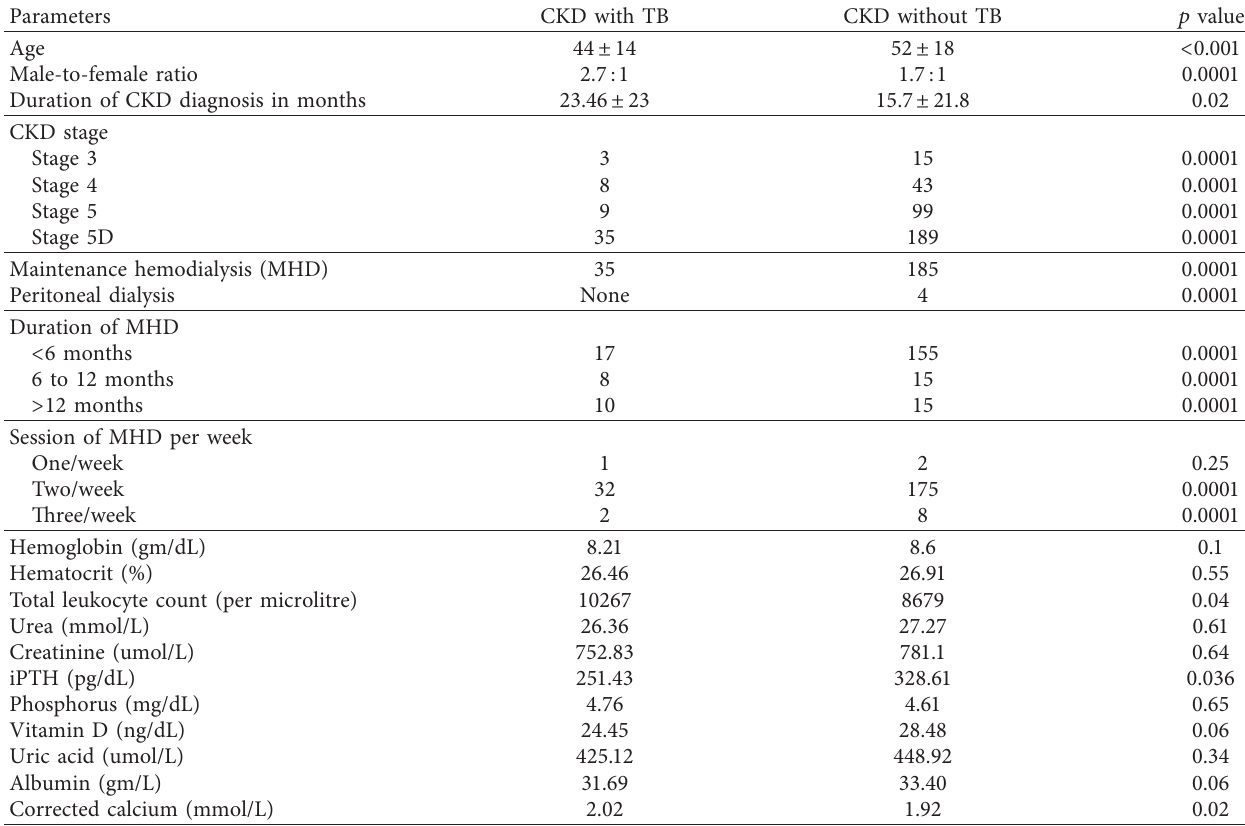
Table 1: Demographic characteristics, staging, and laboratory parameters of CKD patients with and without tuberculosis.